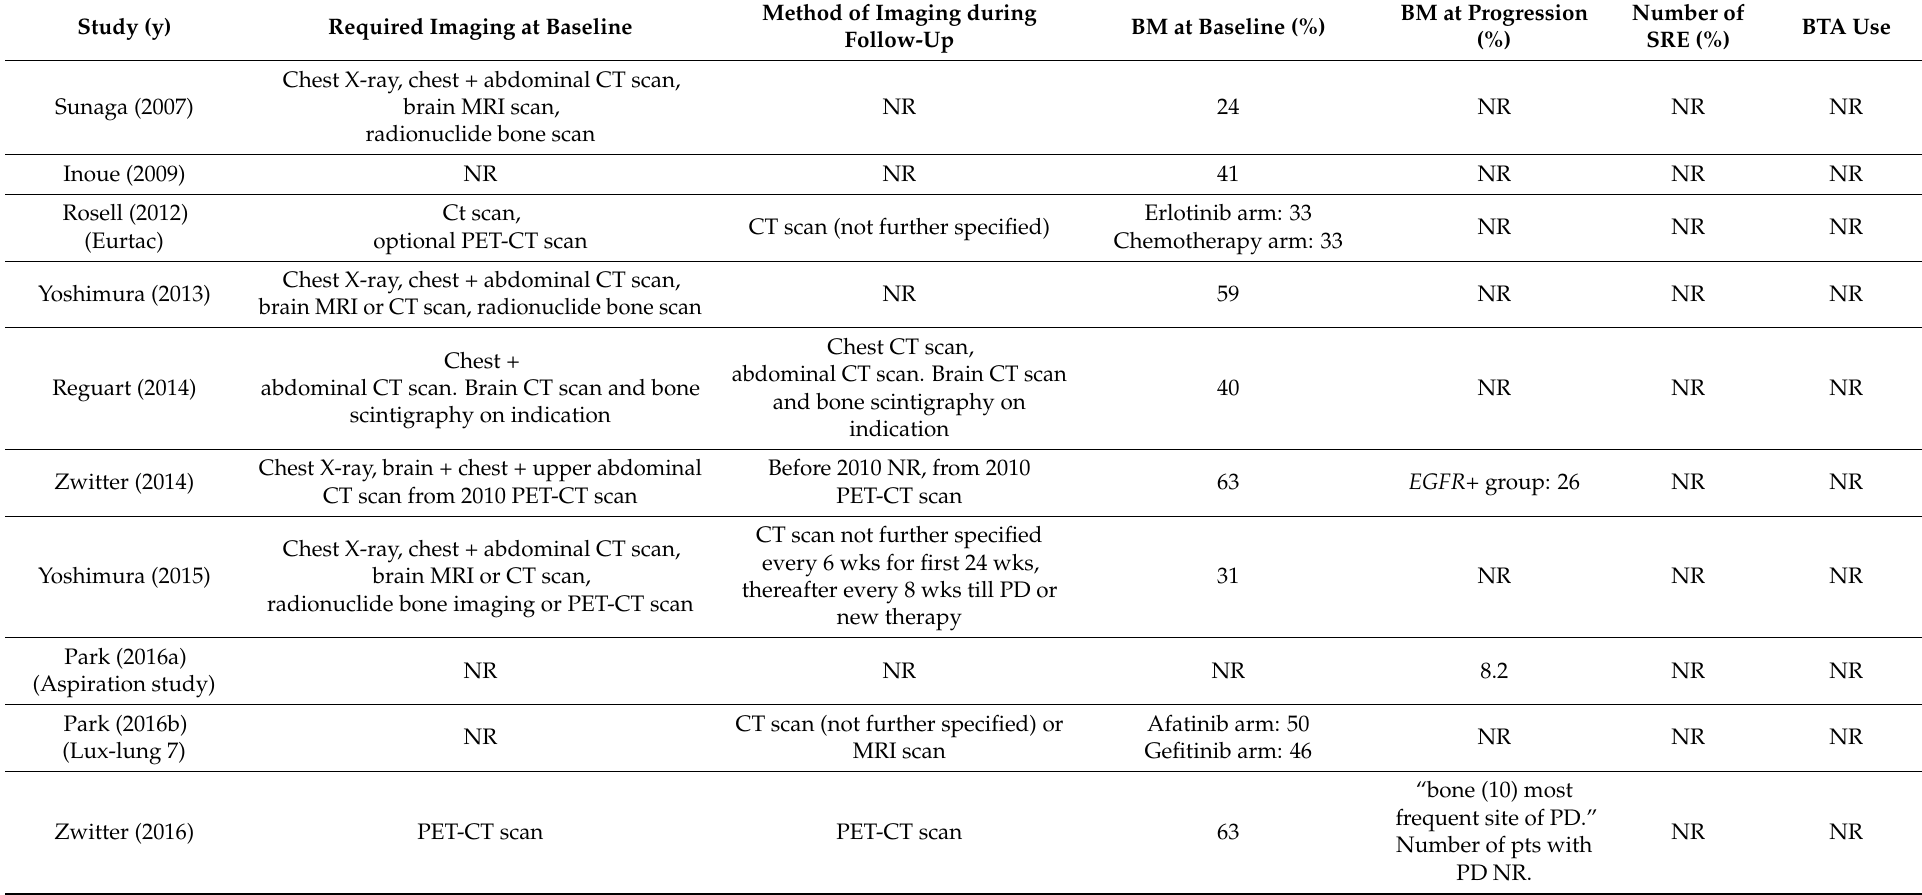
Table 3. Summary of the reported imaging, incidence of bone metastases and SREs of the included